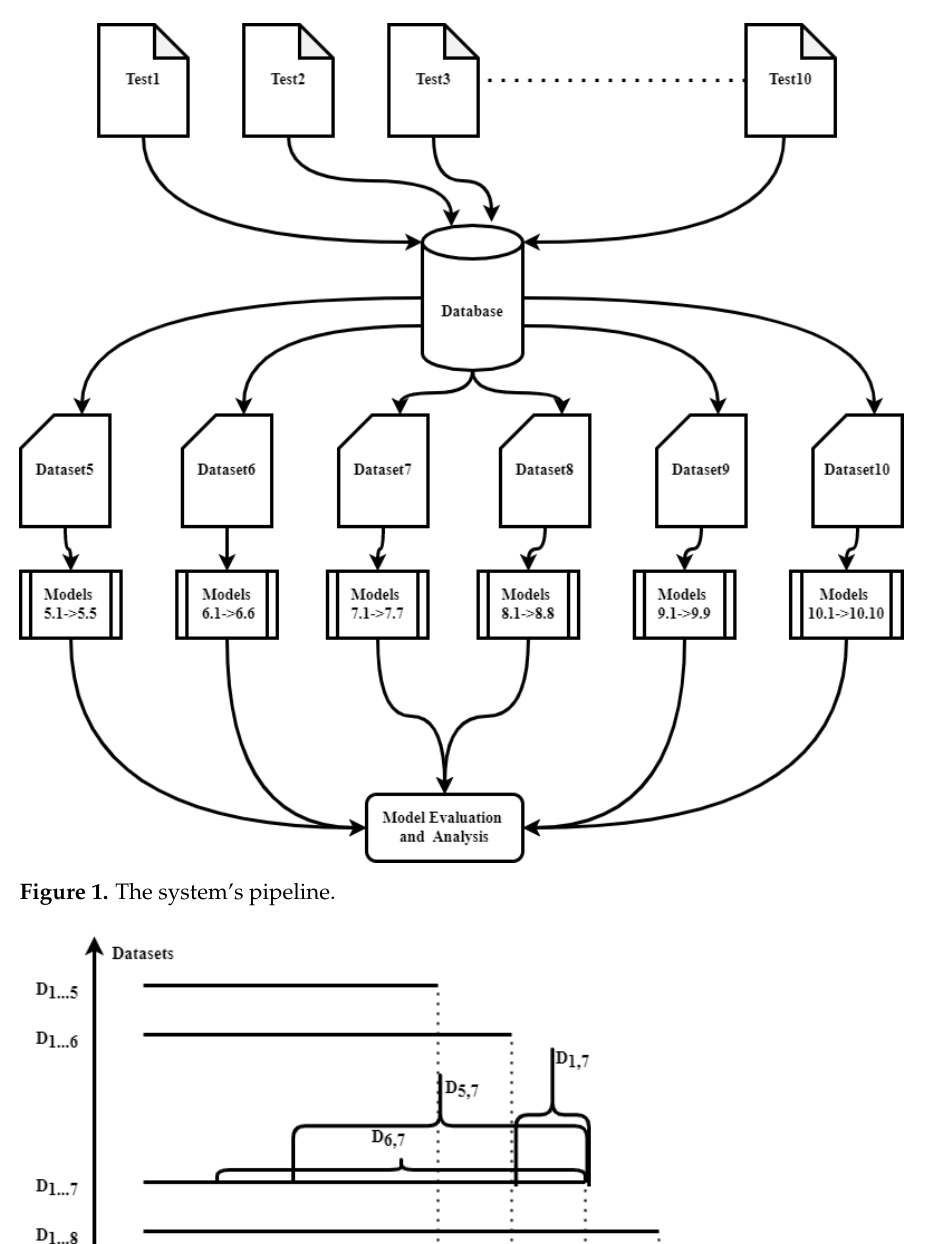
Figure 2. Dataset